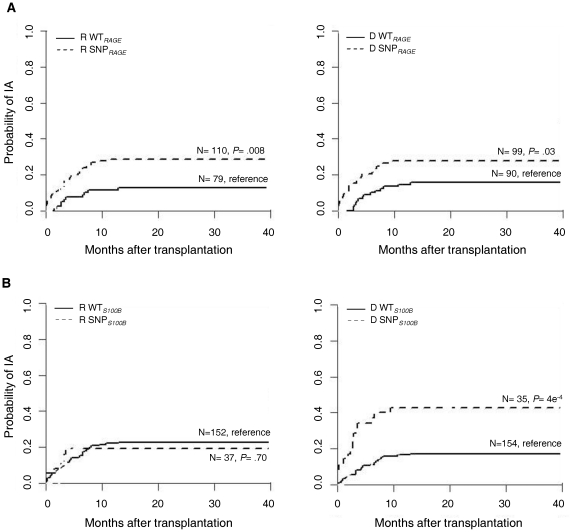
Polymorphisms in the S100B/RAGE axis and risk of IA in HSCT recipients.(A) Cumulative incidence of IA according to RAGE -374T/A genotype (WTRAGE, TT; SNPRAGE, TA+AA). (B) Cumulative incidence of IA according to S100B +427C/T genotype (CC, WTS100B; CT+TT, SNPS100B). From left to right, patients (R) and donors (D).